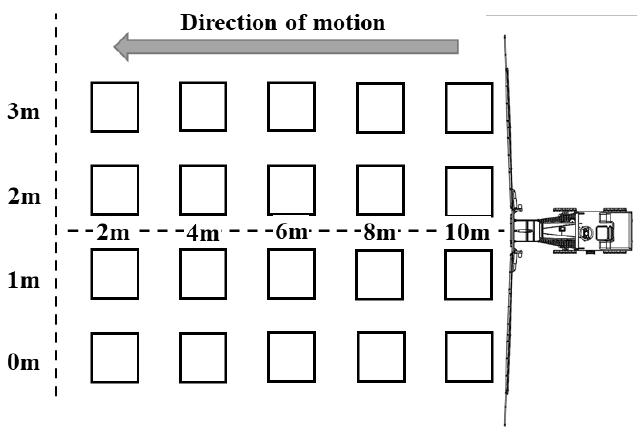
Figure 4. Schematic diagram of the working path and the sampling point position of the applicator.